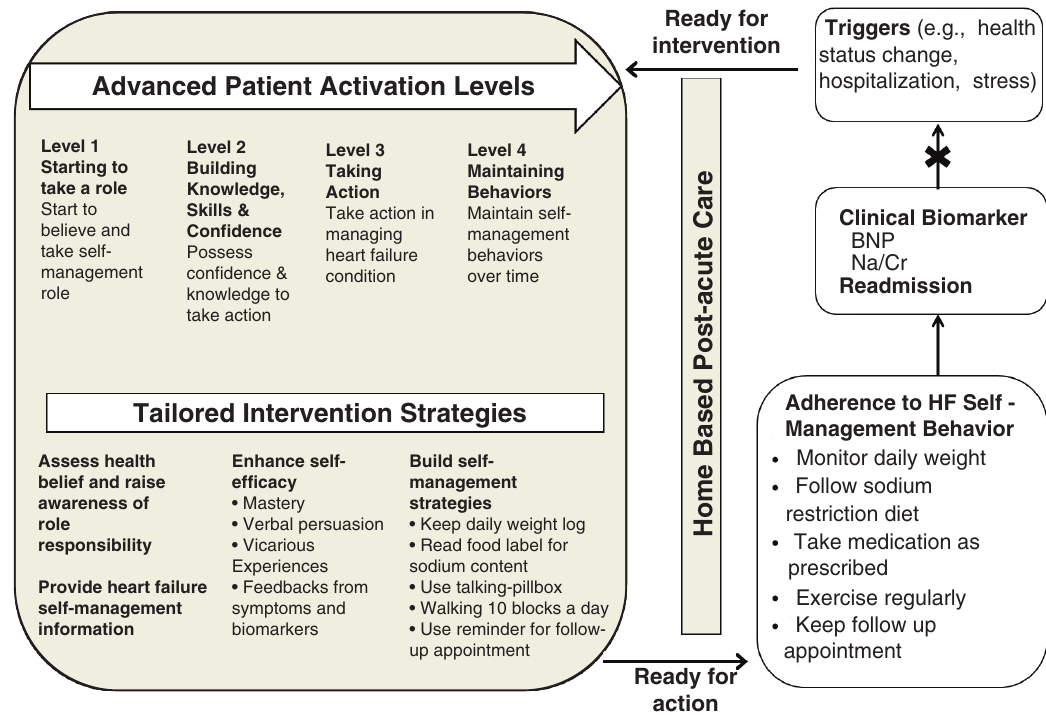
Figure 1. Patient AcTivated Care at Home Model: